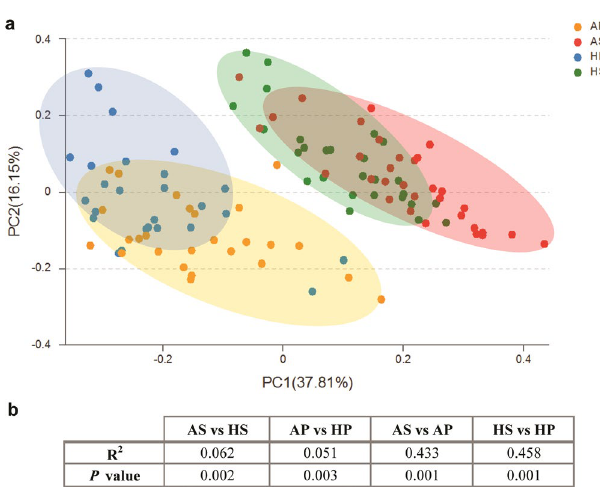
Figure 1. Overall structural comparison of the oral microbiota. Sequences were randomly subsampled to obtain equal numbers of sequences (21,795) from each dataset. ACE index ( a , representing community richness), Shannon index ( b , representing diversity), and Shannoneven index ( c , representing evenness) were calculated for dental and salivary samples. The bars depict mean ± SD of relative abundance rates. * p < 0.05; ** p < 0.01; *** p < 0.001; NS, p > 0.05. HS (saliva samples collected from healthy controls, n = 27); HP (plaque samples from healthy controls, n = 26); AS (saliva samples from ASD patients, n = 32); AP (plaque samples collected from ASD patients, n = 26).